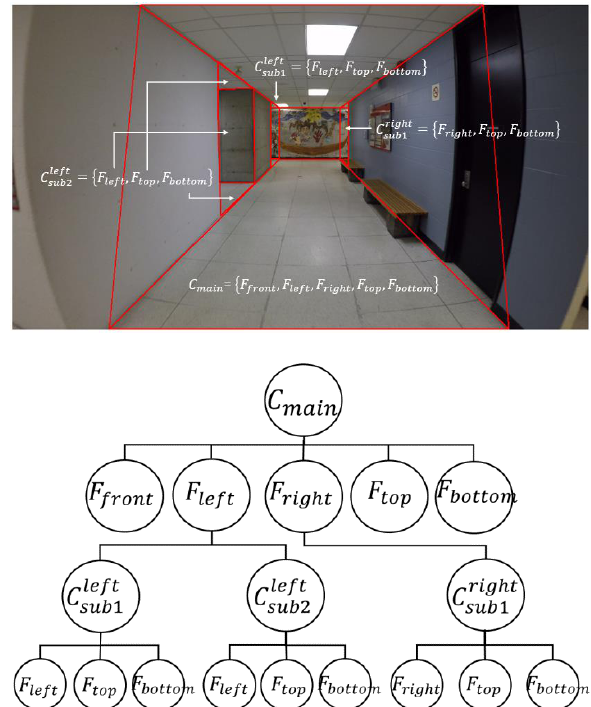
Figure 3. Top: The image of a test frame with all of its specified corridors; Bottom: The respective corridor topological graph of the same test